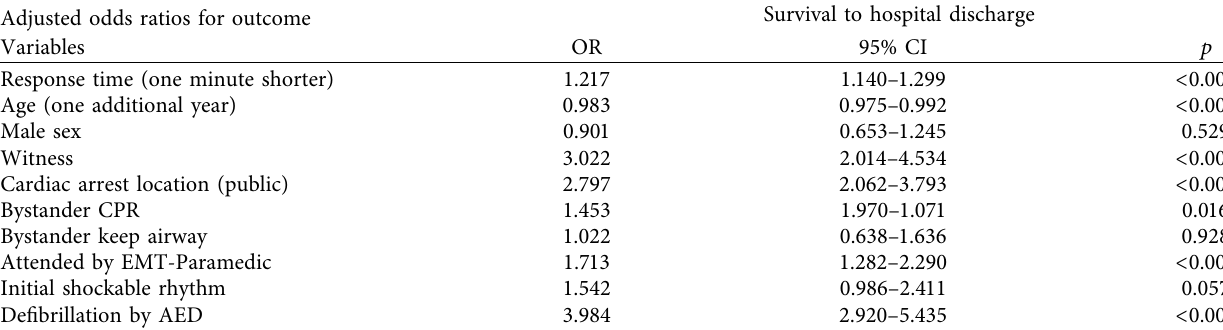
Table 2: Adjusted odds ratios for survival to hospital discharge.